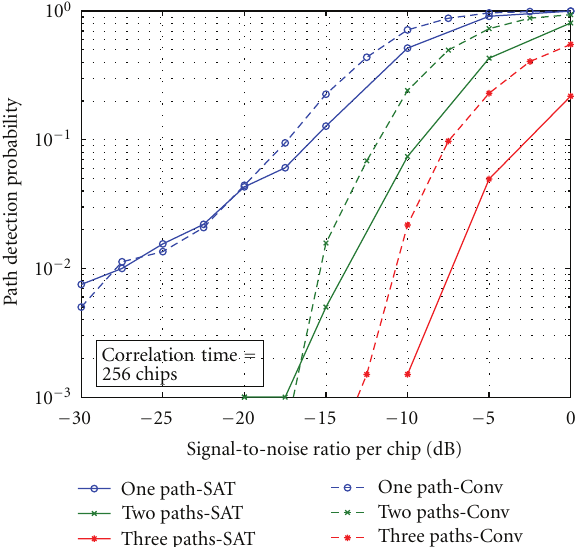
Figure 7: Probability of detection with 1024 chips correlation.